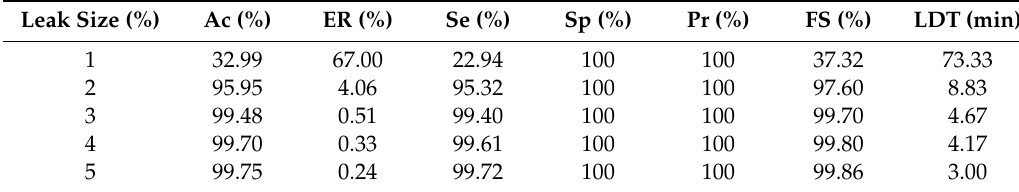
Table 8. Leak detection system performance measures with ascending leak sizes, noise was kept 0.2%; 1201 parameters are used for the mass flow rate